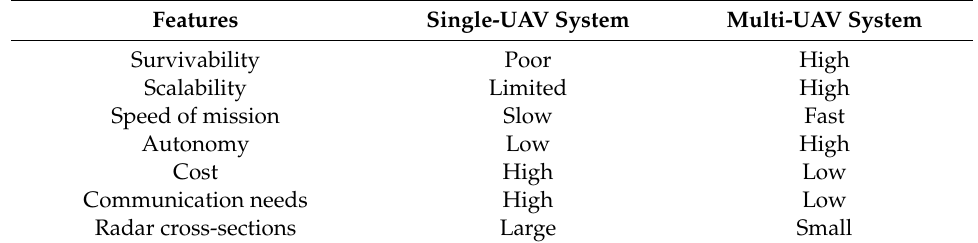
Radar cross-sections Large